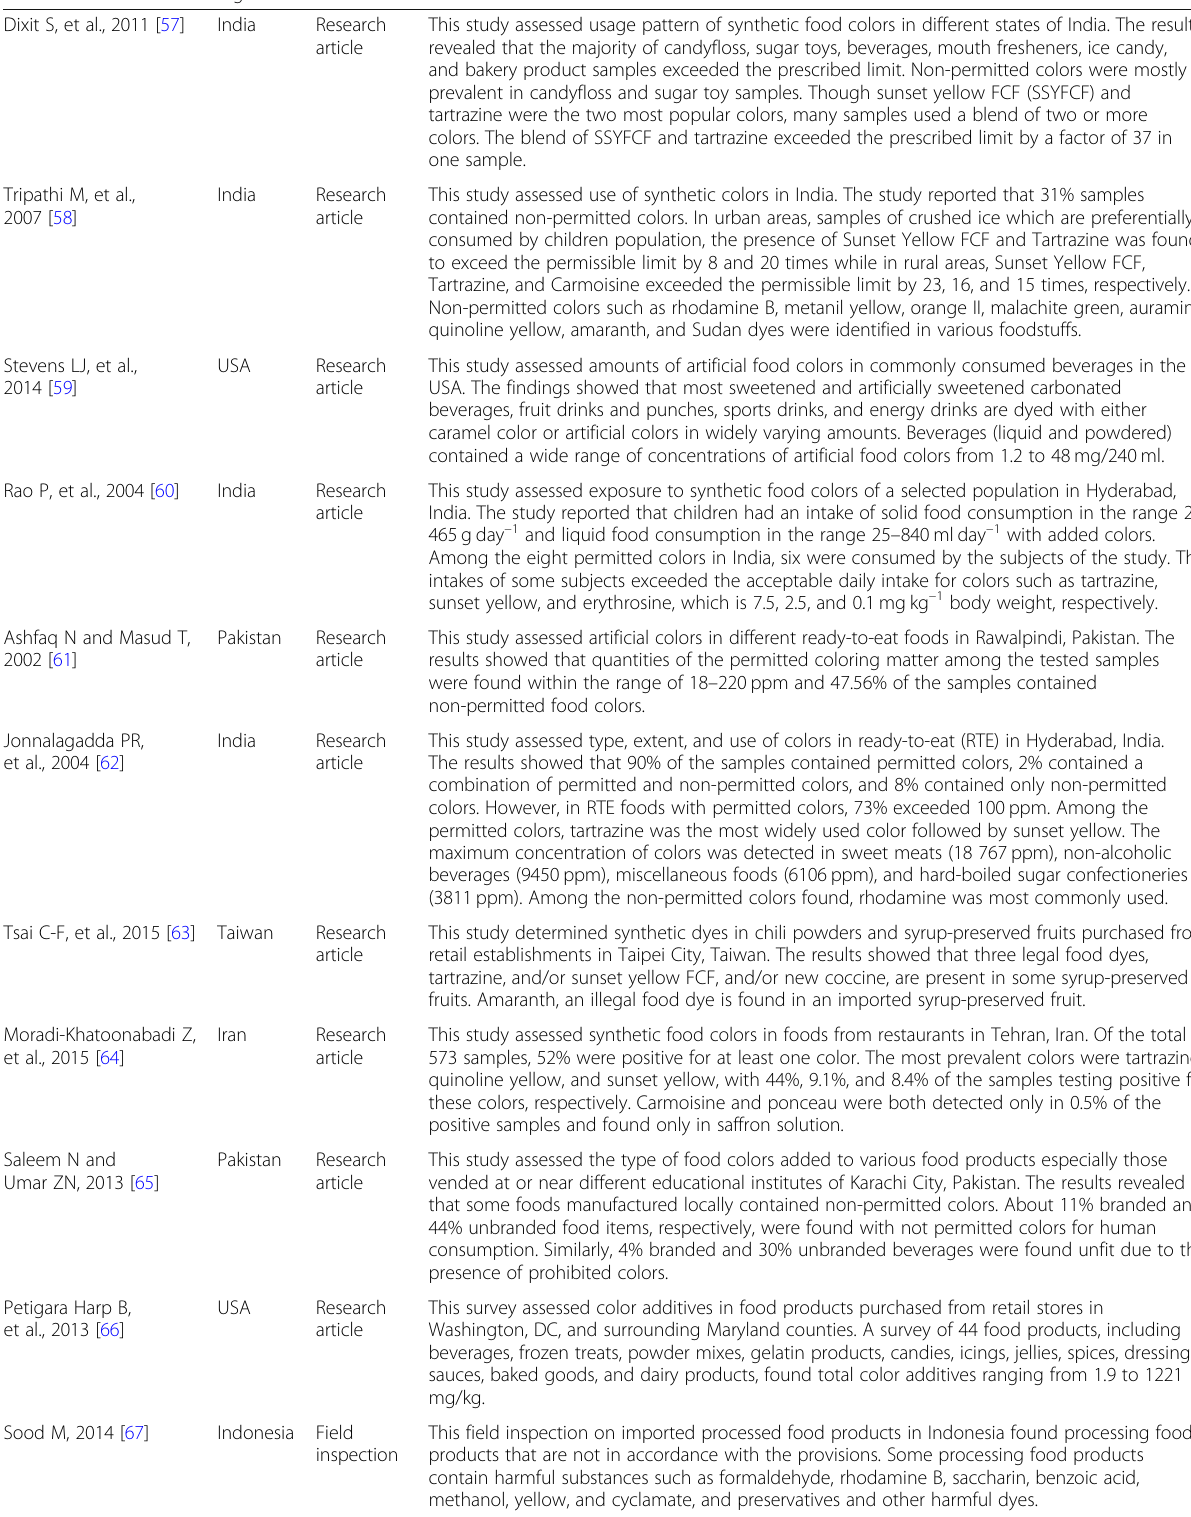
Table 6 Summary of full-text articles which reported misuse of food additives as a public risk in food marketing